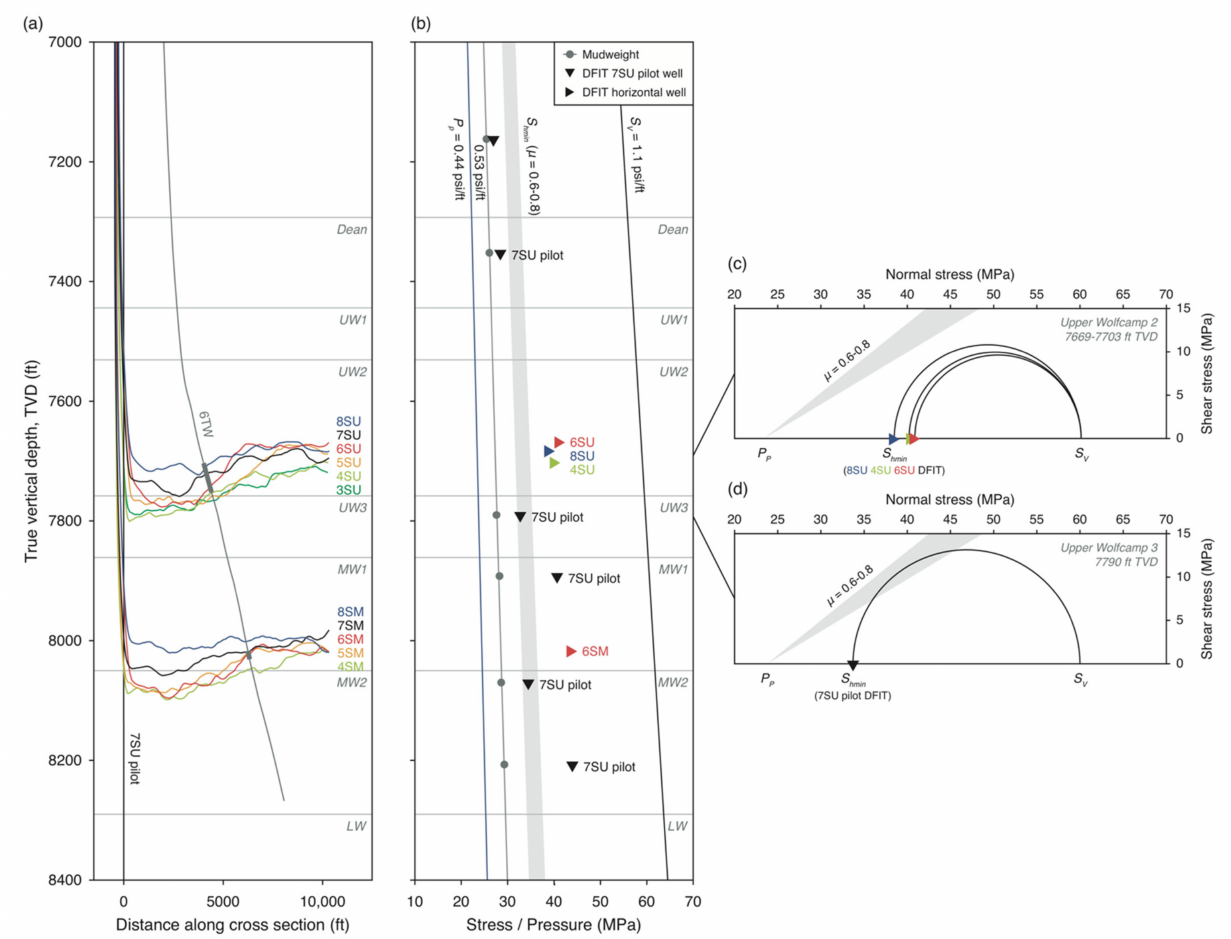
Figure 2. ( a ) Cross section of well trajectories in the Upper and Middle Wolfcamp. Slant well 6TW was cored in two locations (cores 1–4 and 5–6), indicated by the grey boxes on the well trajectory. Grey lines indicate formation tops designed in the 7SU pilot well. LS: Lower Sprayberry, UW: Upper Wolfcamp, MW: Middle Wolfcamp, LW: Lower Wolfcamp. ( b ) Stress profile incorporating measurements of drilling mudweight and diagnostic formation integrity tests (DFITs) in both vertical and horizontal wells. Grey area shows S hmin predicted by frictional equilibrium for friction coefficients, µ = 0.6–0.8. ( c ) Mohr circles representing the variation in stress state in the UW2 unit at 7769–7703 ft based on DFIT measurements from horizontal wells 4SU, 6SU, and 8SU. ( d ) Mohr circle representing the stress state in the UW3 unit at 7790 ft based on DFIT measurements in the 7SU pilot